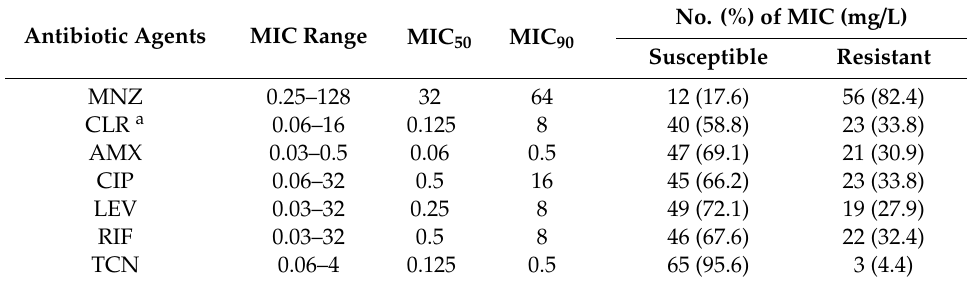
No. (%) of MIC (mg / L) Susceptible Resistant